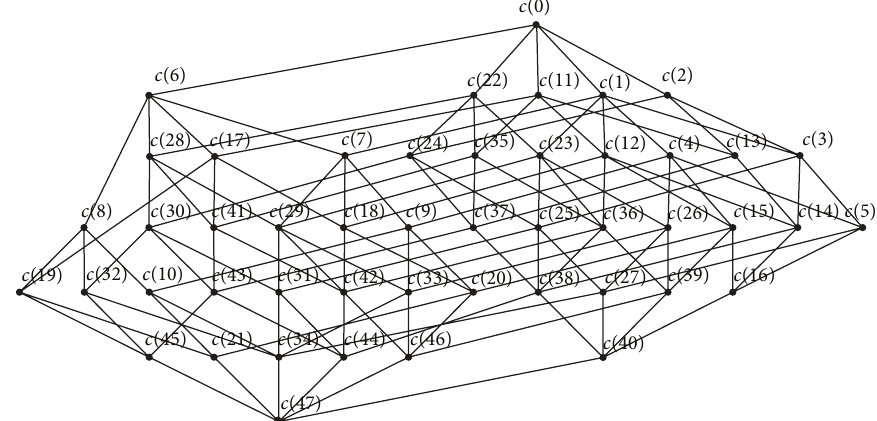
Figure 14: Hasse diagram of the formal context presented in Table